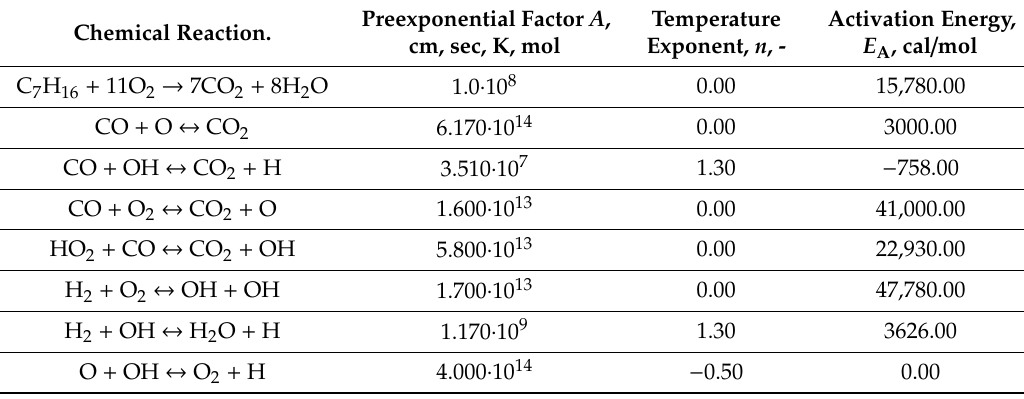
Table A1. The chemical reactions system in the numerical model of HFO combustion. Chemical